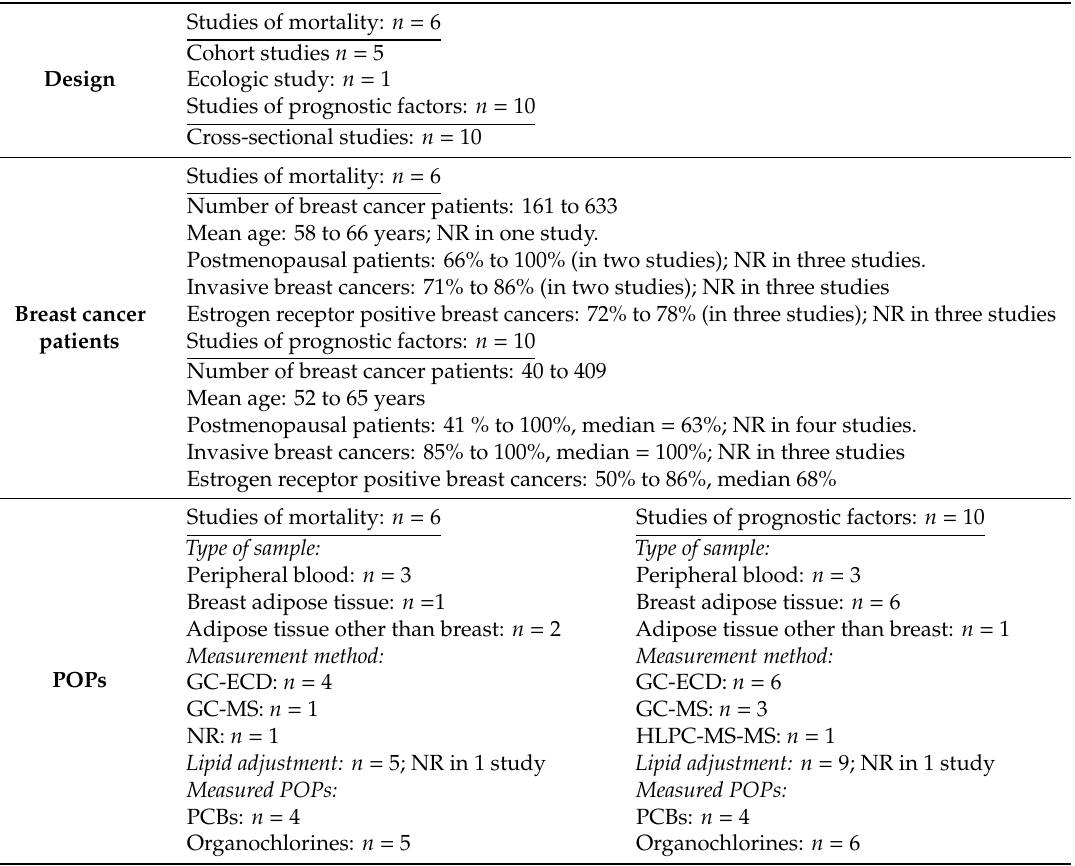
Table 3. Summary characteristics of studies of POPs and breast cancer prognosis ( n =